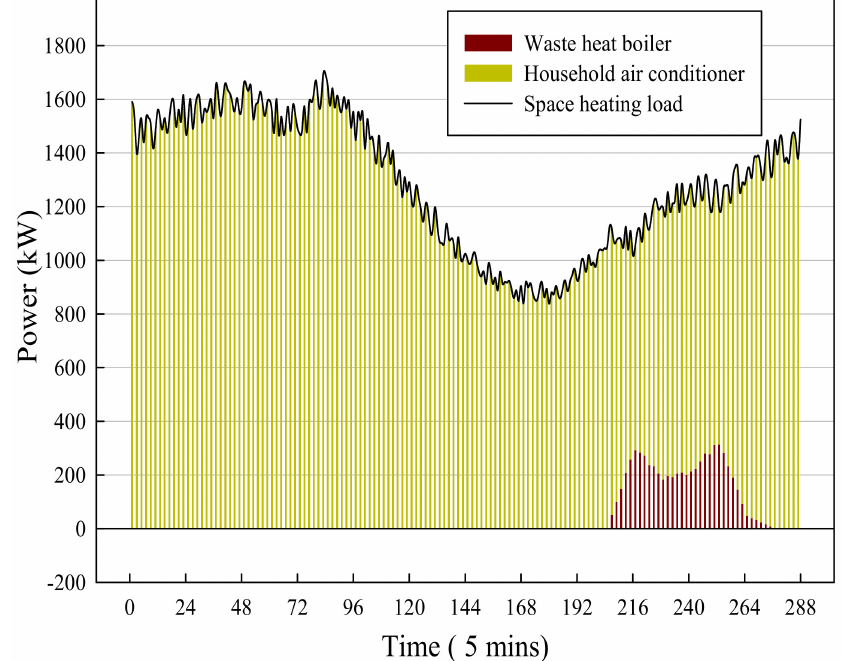
Figure 9. Real-time balance curve of space heating